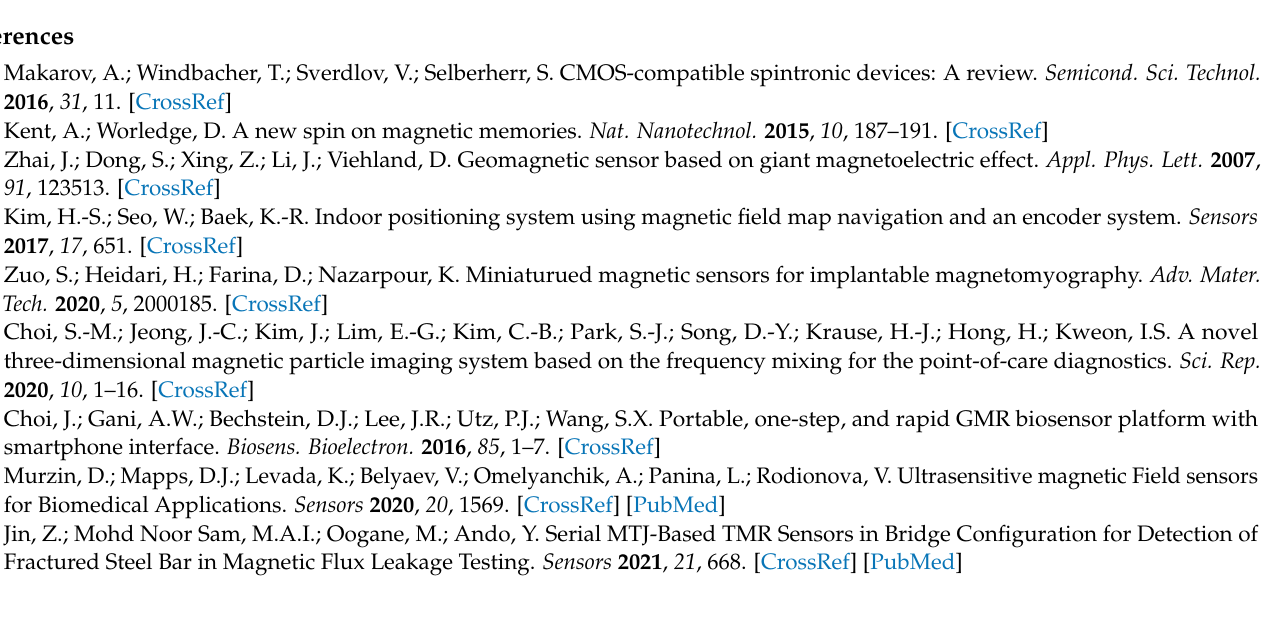
Figure A2. ( a , b ) Field detectivity for bi-layered cPHMR and mPHMR sensors at 30 °C and 90 °C. Equivalent magnetic noise, or detectivity data was fitted with Equation (14). These measurements were carried out to investigate the NSDs’ dependence on CC and CV modes.